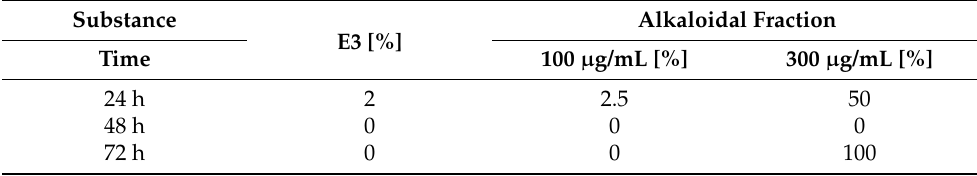
Table 2. Zebrafish embryo mortality.